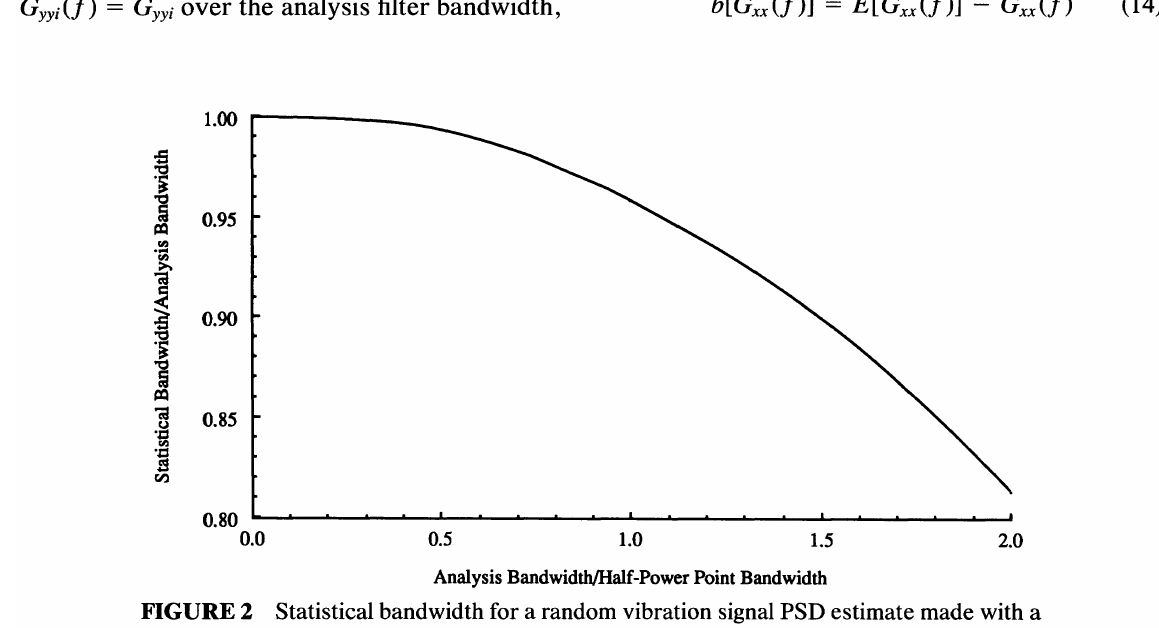
FIGURE 2 Statistical bandwidth for a random vibration signal PSD estimate made with a rectangular filter centered on a spectral